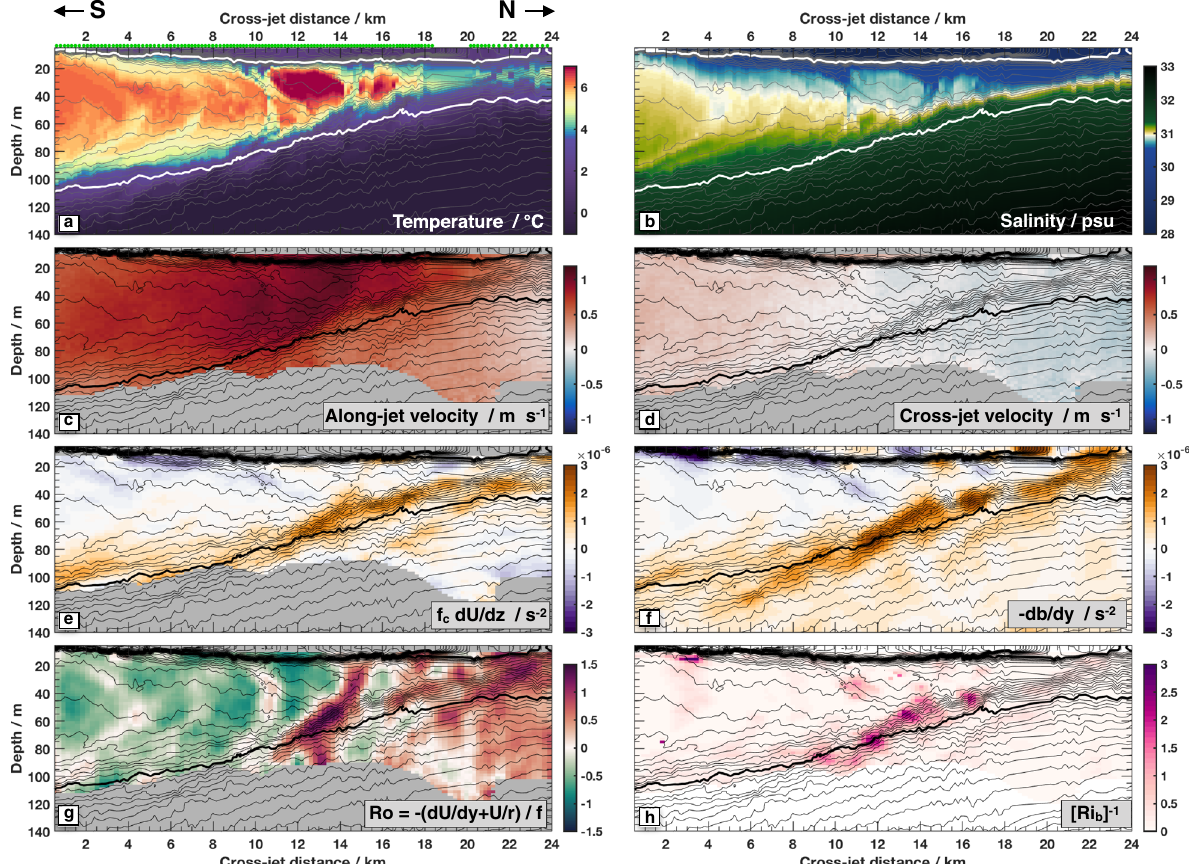
Fig. 2 A slice through the meandering jet taken on 15 Sept 2018 (location shown in Fig. 1c ). On all panels, isopycnals are contoured every 0.1 kg m 3 (thin black lines), with the 23.2 and 25.2 isopcynals in bold white or black. Color shading in each panel represents a temperature; b salinity; c along-jet velocity, which has been rotated 23.4° southward of East; d cross-jet velocity; e vertical derivative of along-jet velocity scaled by the inertial frequency adjusted by the jet curvature ( f c , Methods); f cross-jet buoyancy gradient; g the Rossby number, Ro, a non-dimensional measure of the relative vorticity (Methods), h inverse Richardson number, Ri b , calculated from the lateral buoyancy gradient assuming thermal wind balance (Methods). Both Ro and Ri b take on values with magnitudes close to one indicating that the fl ow follows submesoscale dynamics. The green dots above a show the location of each FCTD pro fi le, which are interpolated between for plotting purposes. Arrows above a indicate rough Northward and Southward directions, and the magenta/cyan dots are also shown in Fig. 1c, for